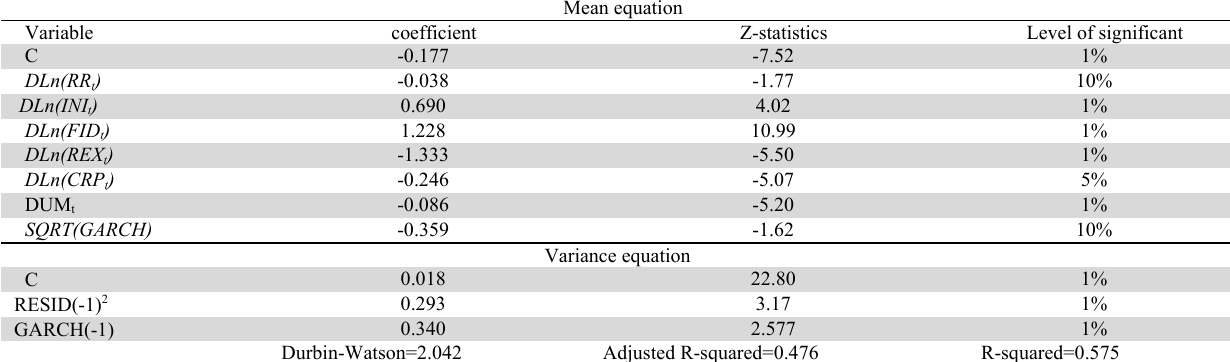
Results of estimating the model, )(